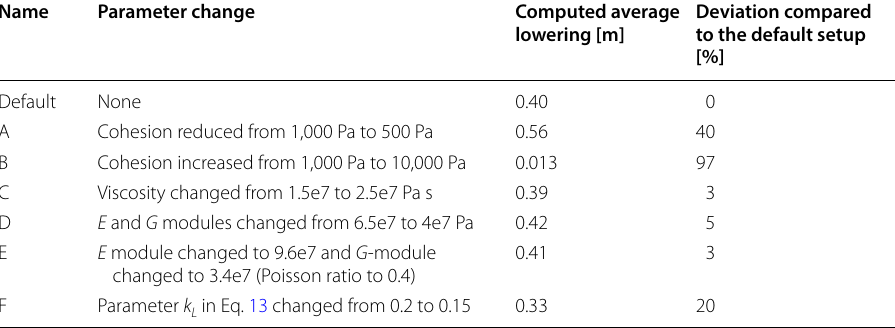
Table 1 Computed average bed lowering from the parameter sensitivity